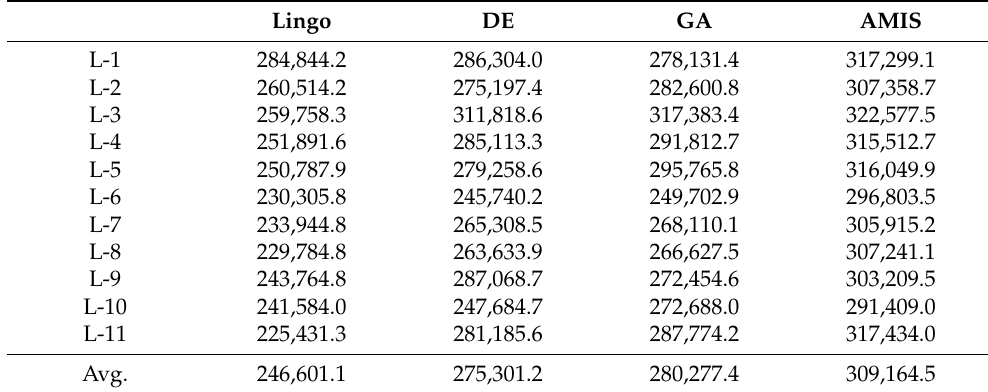
Table 17. Average profit per container.